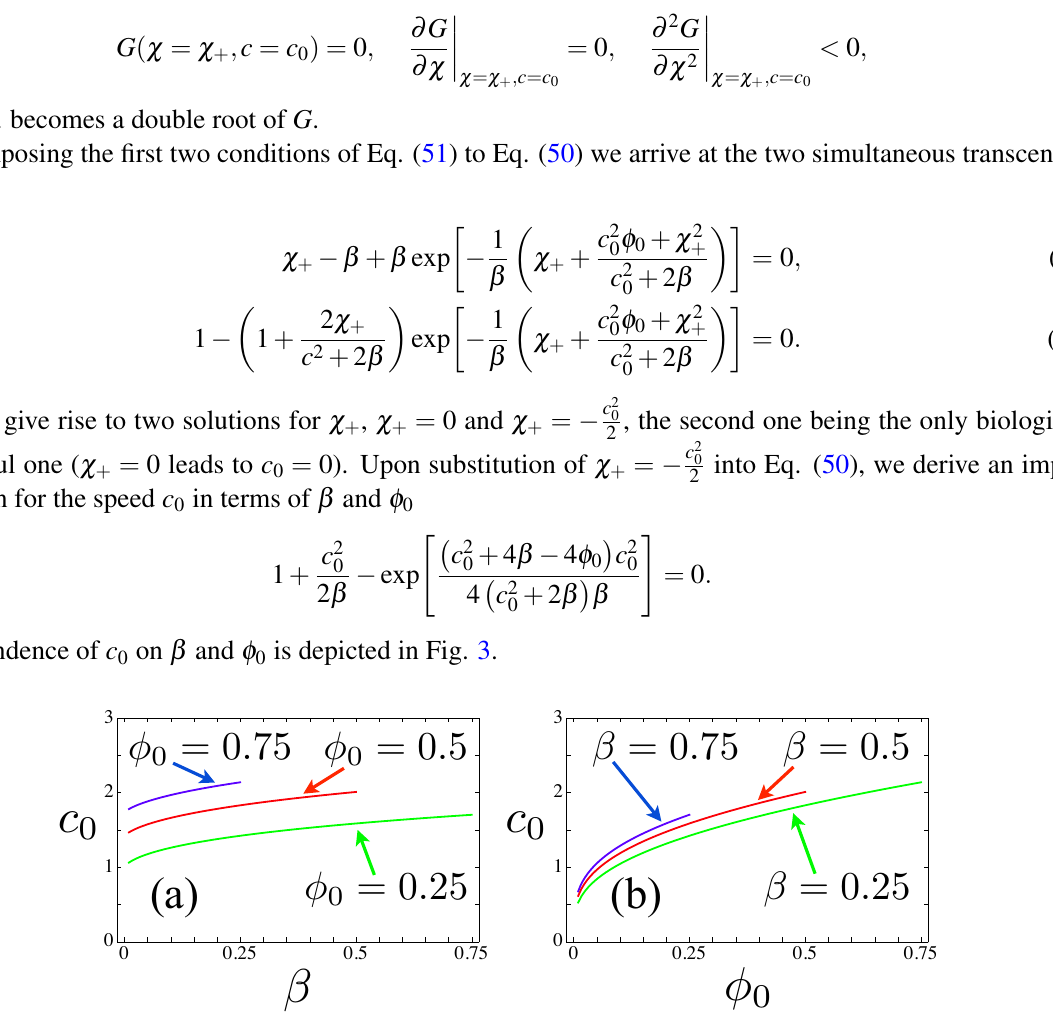
Fig. 3 Characteristic curves of the minimum speed c 0 for positive bright solitary solutions, in terms of (a) β and (b) φ 0 , calculated from Eq.